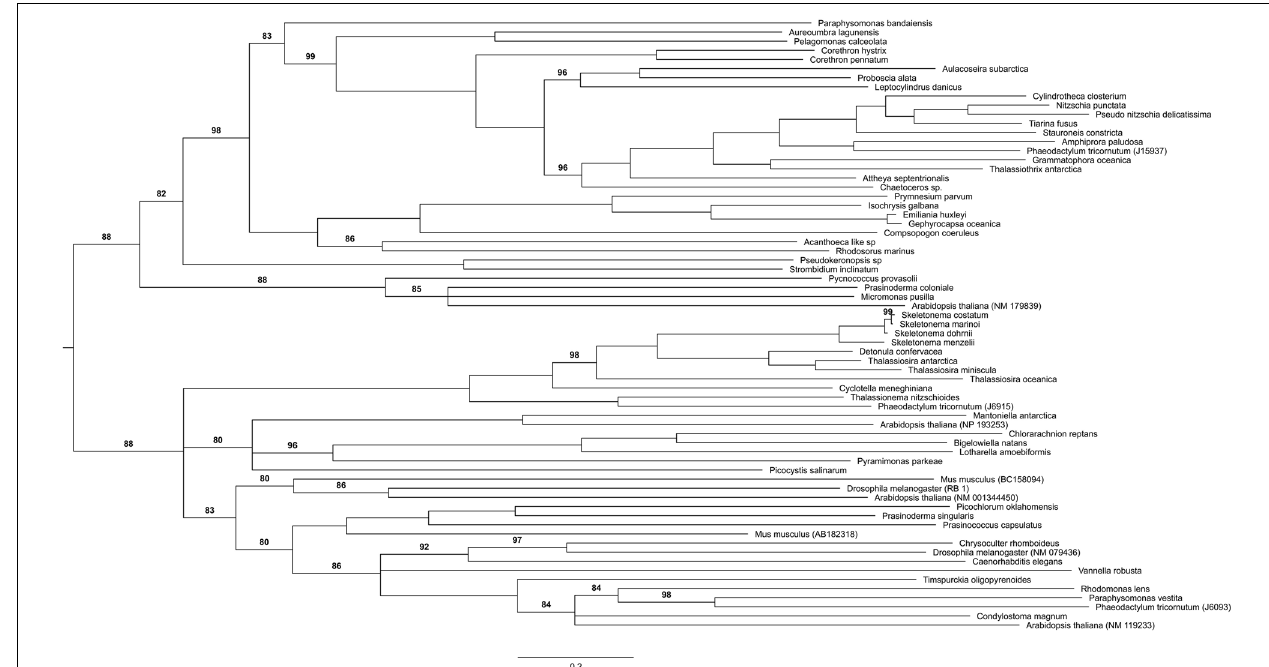
FIGURE 6 | Phylogenetic tree of TrxG